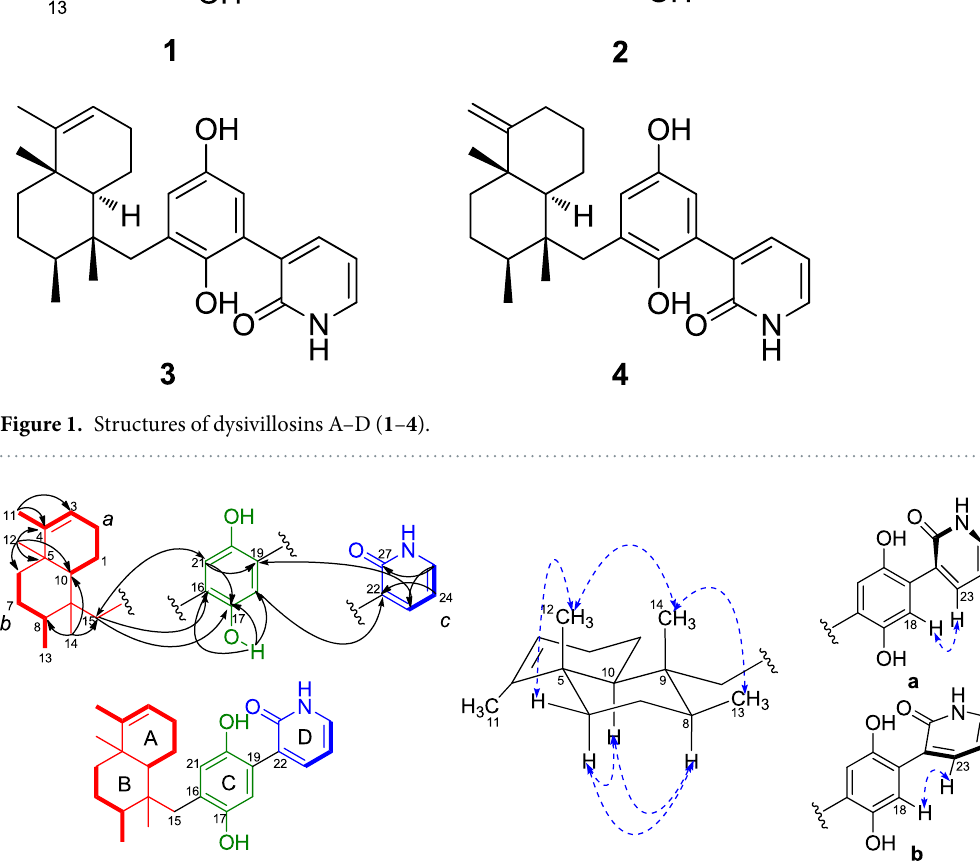
Figure 2. Key COSY, HMBC, and NOESY correlations of 1